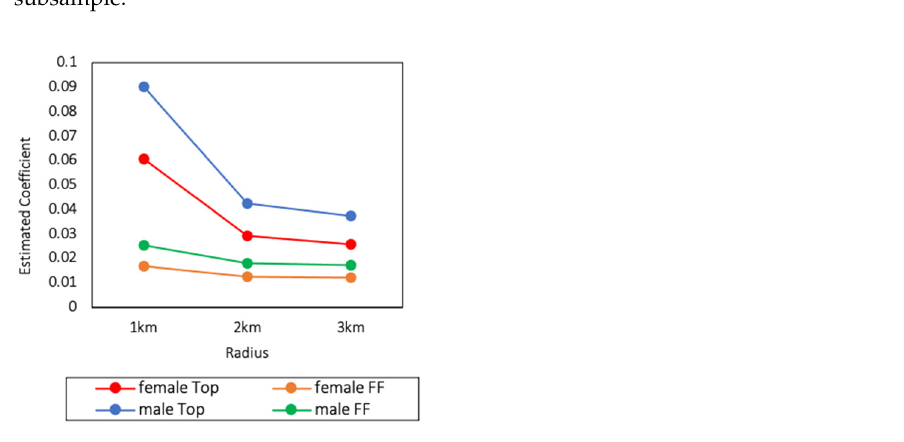
Figure 4. Estimated coefficients of the number of Tops and FFs within 1, 2, and 3 km of the female and male